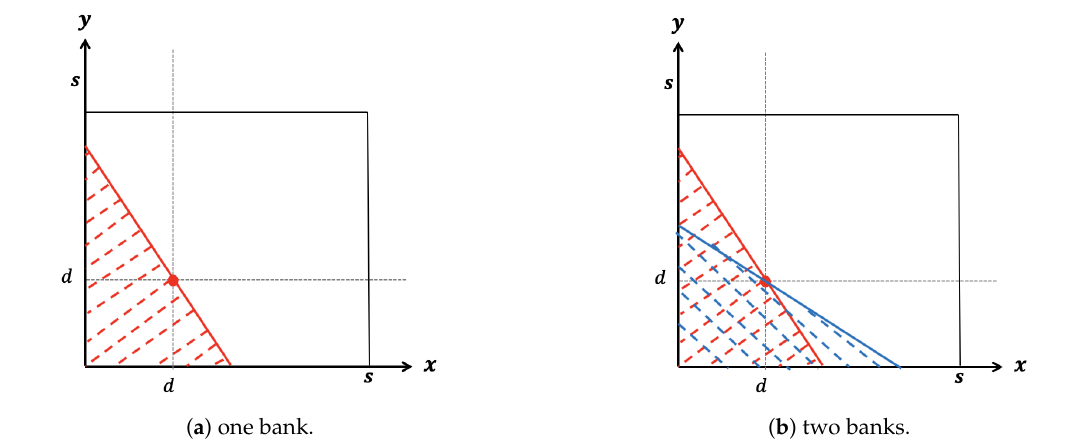
Figure 2. Bank run outcomes in case of linear diversification. ( a ) one bank ( b ) two